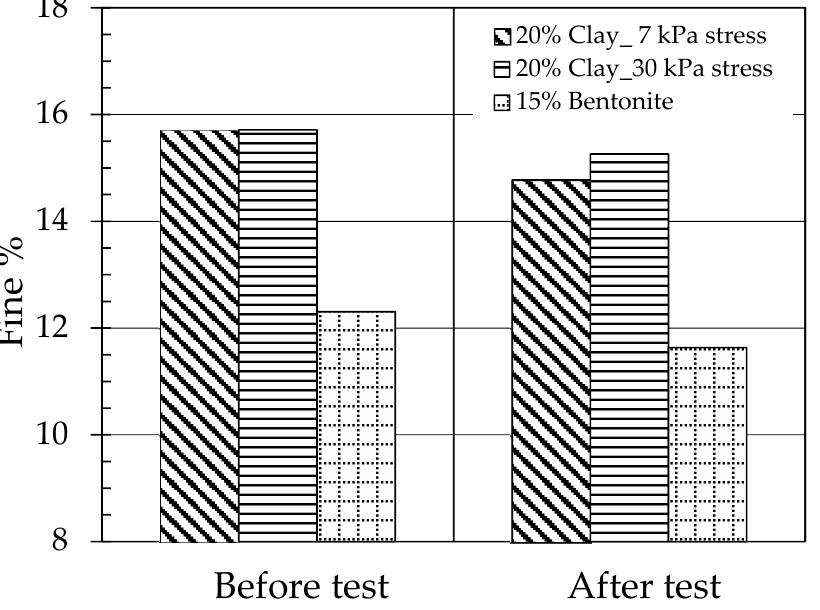
Figure 8. Fine percent before and after extended time hydraulic conductivity tests for different mixtures. When the vertical applied stress is increased the hydraulic conductivity is decreased as voids will compress. The tunnels or water passways will constrict, thus retarding water flow. The higher stresses can consolidate and cause the clay fabric to change. Comparing Figures 5 and 7 for the 150 days’ measurements, the hydraulic conductivity is increased by more than two orders of magnitude (5 × 10 − 7 to 0.2 × 10 − 5 ). The application of vertical stress of 30 kPa was found to stabilize the constituents of the mixtures and reduce the loss of fines in cases of no F-T action, while the notable drop and repeated waves have been noticed for specimens subjected to multiple F-T